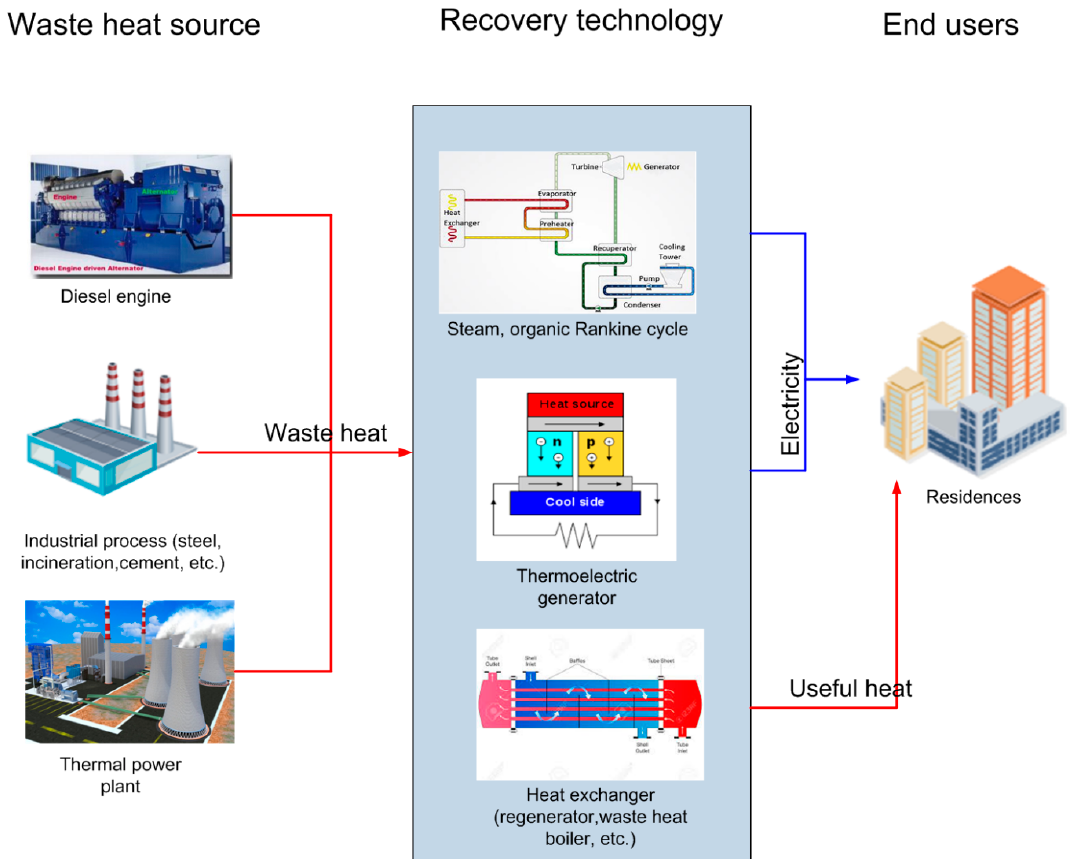
Figure 1. Conventional industrial waste heat sources and recovery technologies.